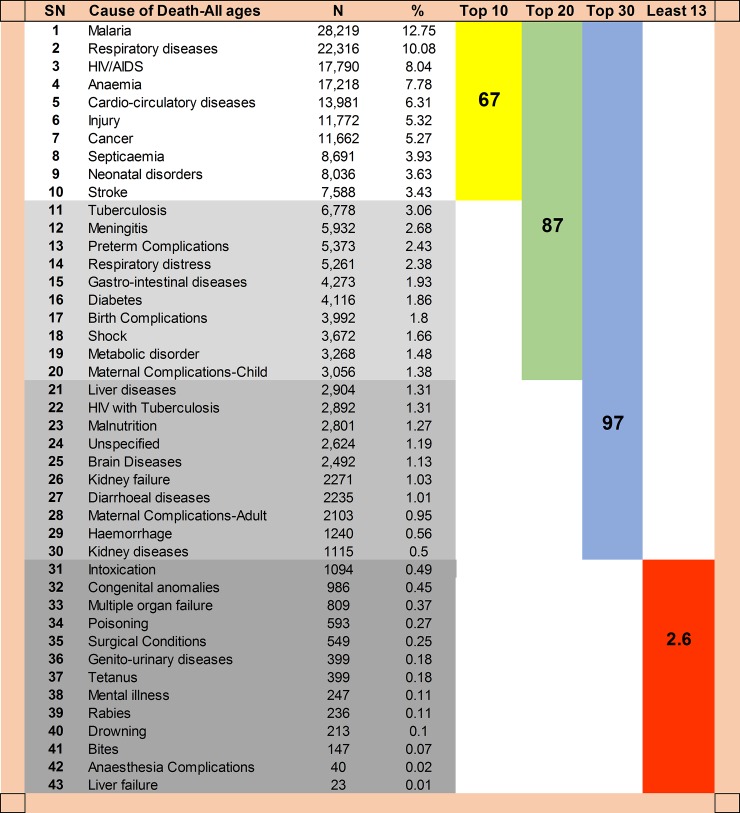
Cumulative proportion of death by cause of death groups for all ages.